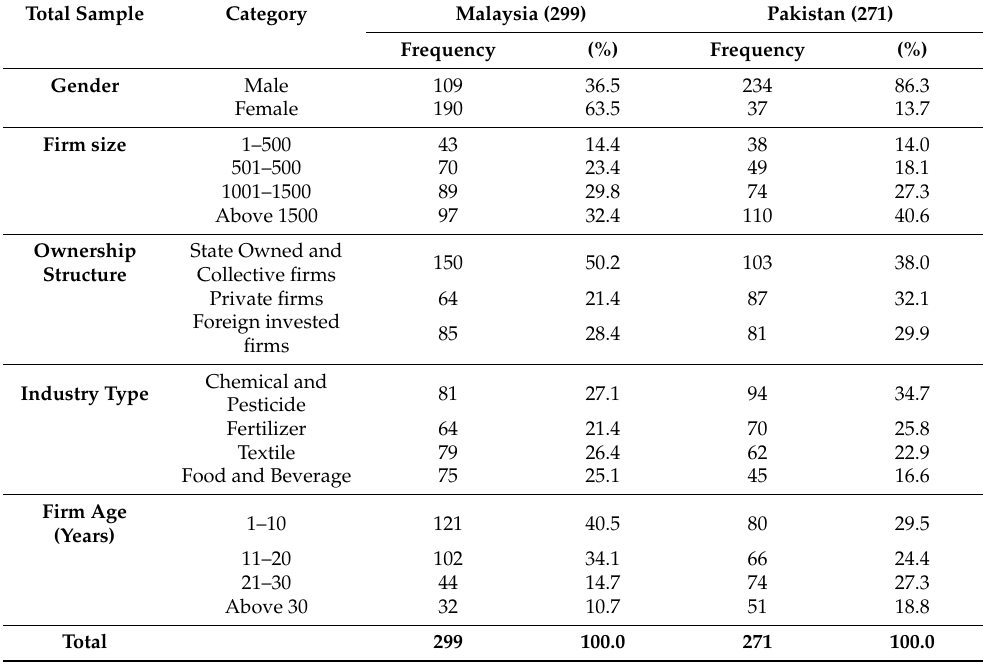
Table 1. Demographic Profile.